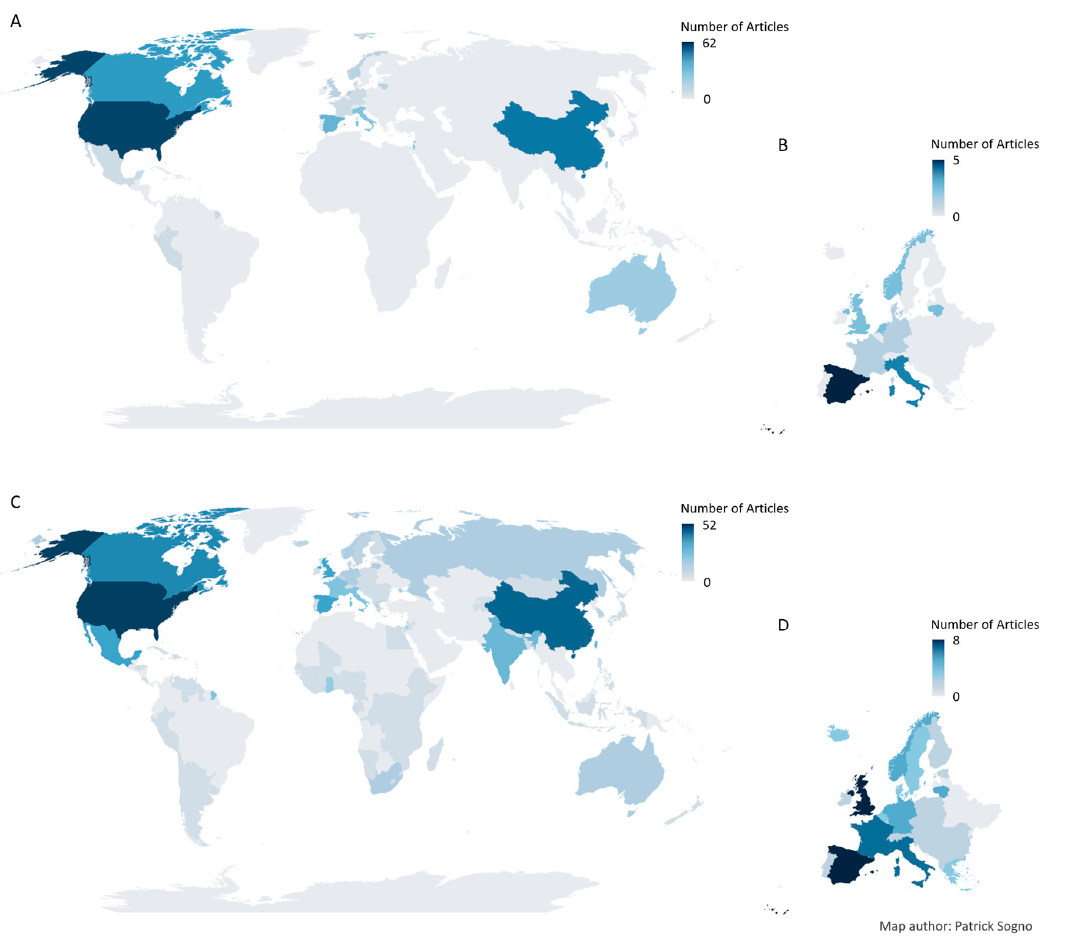
Figure 4. Global distribution of first authors research institutions ( A ) and detailed view on Europe ( B ). Global distribution of focus countries of the studies (independent of author affiliation) in reviewed articles ( C ) and detailed view on Europe ( D ).